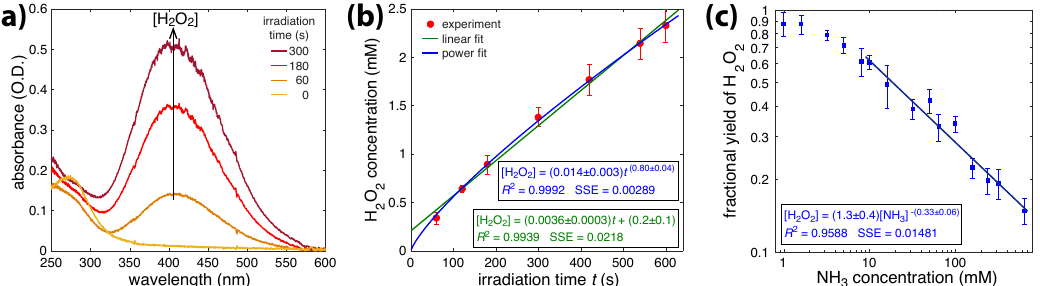
Figure 1. ( a ) Absorption spectrum of TiO to irradiated water; ( b ) H with with linear (green) and power (blue) functions; ( c ) Log–log plot of fractional H concentration with linear fit a 10–600 mM NH over four independent